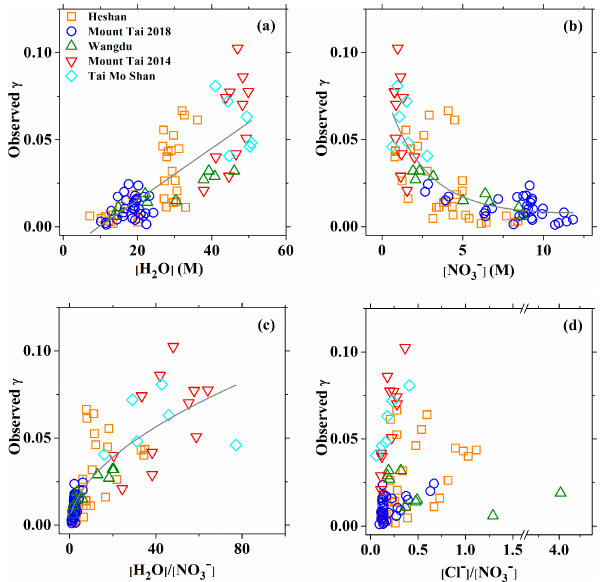
Figure 2. Relationship between the field-measured or derived N 2 O 5 uptake coefficient γ N and (a) aerosol water content, (b) particle 2 O 5 nitrate, (c) H 2 O to NO − molarity ratio, and (d) Cl − to NO − mo- 3 3 larity ratio. Green triangles, red triangles, cyan diamond symbols, orange squares, and blue circles represent the results of Wangdu in 2014, Mount Tai in 2014, Tai Mo Shan in 2016, Heshan in 2017, and Mount Tai in 2018, respectively. The solid lines are linear or exponential